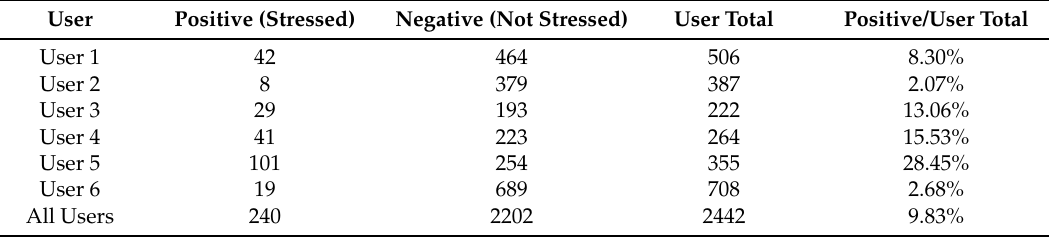
Table 2. Observation note instances per user, showing the positive and negative count, and positive instances percentage to